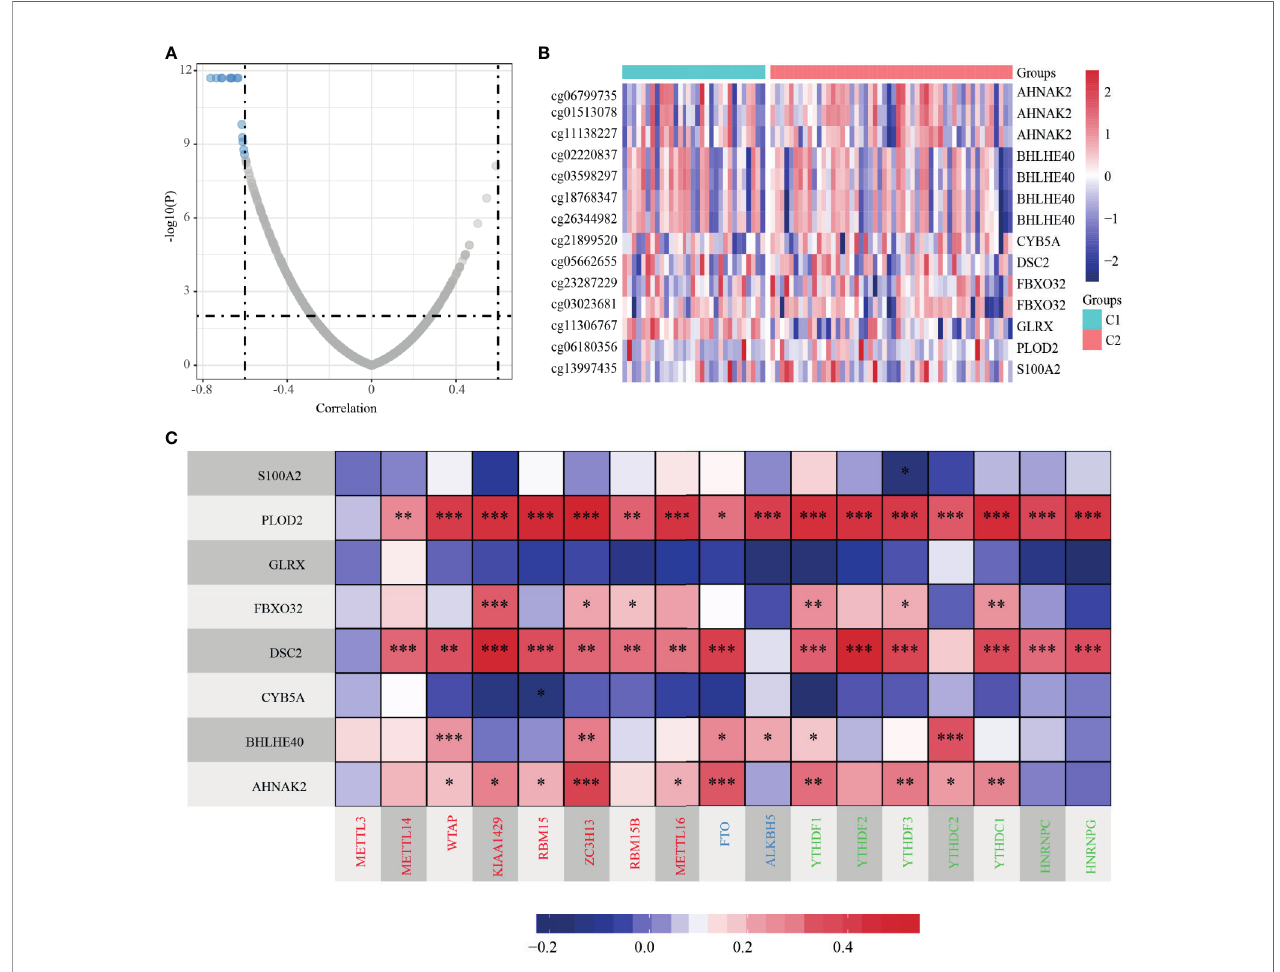
FIGURE 5 | Methylation characteristics of dHRGs. (A) The correlation coef fi cient and p -value of dHRGs-related methylation sites. (B) The methylation level in TCGA-TNBC subgroups. (C) The correlation between expression level of dHRGs and critical genes in m6A process (***, **, and * represent p < 0.001, p < 0.01, and p < 0.05, respectively). The abscissa in (C) includes genes involved in the m6A process, Red represents Writers, Blue represents Erasers, and Green represents